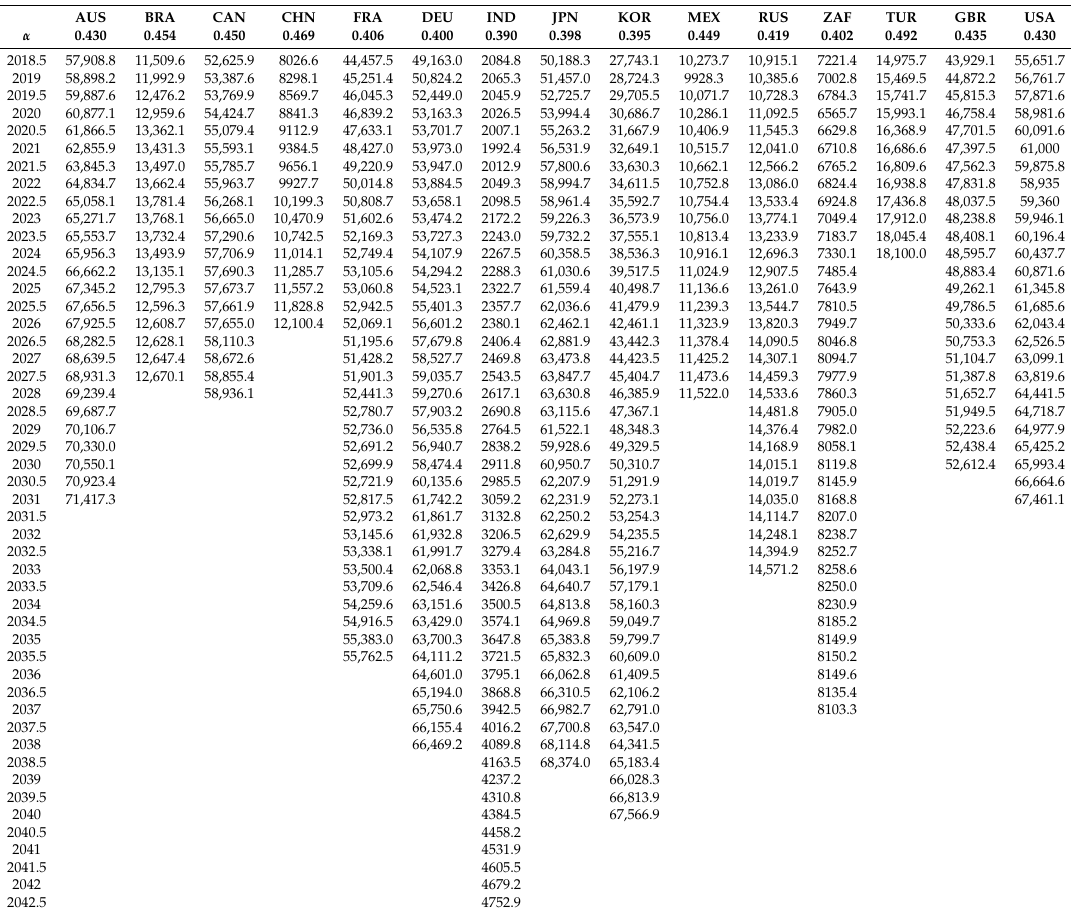
Figure 11. The real and predicted PPS for the set of 15 countries. Table 3. Estimation of GDP per capita for the set of 15